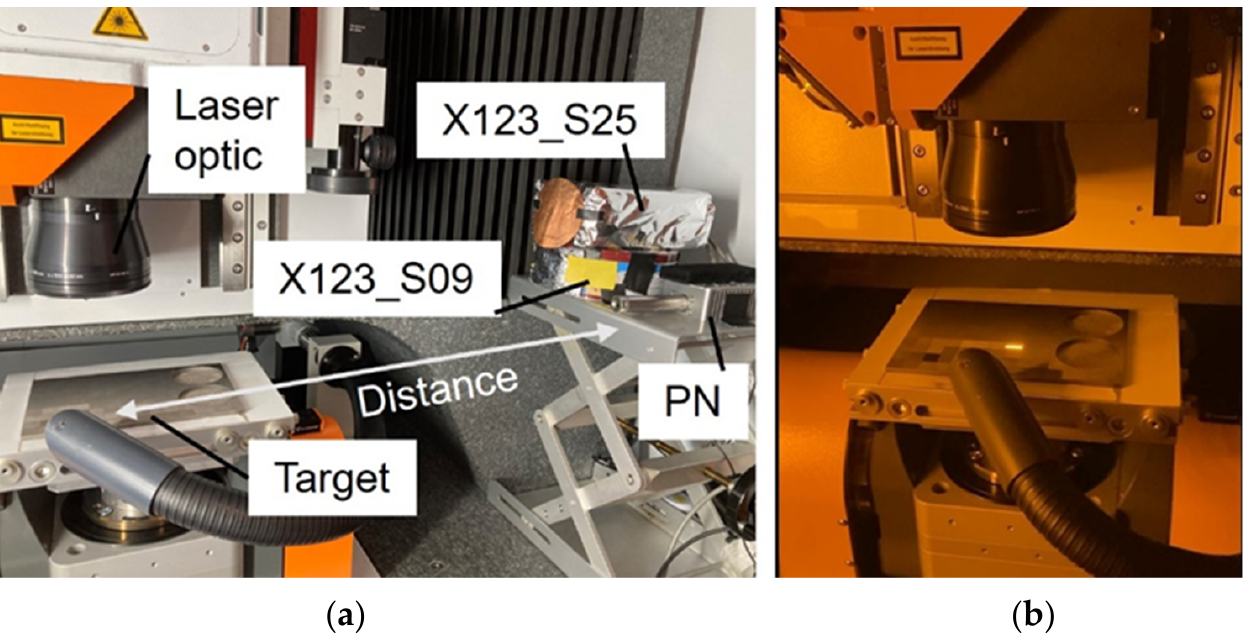
Figure 1. Experimental setup, ( a ) Arrangement of the spectrometers, ( b ) Image during laser processing. The X-ray emission investigations showed EMC issues for both CdTe spectrometers (X-123). The SDD (PN) was not affected. To reduce the influence due to the EMC issues, the X-123 spectrometers were encased in special housings. The X123_S09 was placed in a tinplate box and the X123_S25 in an aluminum box. To further suppress electronic noise, aluminum foils were put in front of the measurement window. The thickness of the aluminum foils (different thicknesses for X123_S09 and X123_S25) was calculated from absorption measurements using an X-ray tube with and without aluminum foils (see Section 3.1). To evaluate the influence of pile-up effects on the measured spectra, the measurements were performed with and without a 50 µ m thick copper foil (see Section 3.1). The placement of the spectrometers with respect to the X-ray emission source and its spatial homogeneity was controlled with a radiographic imaging plate placed at a distance of 60 cm from the laser-induced emission source about 10 cm in front of the three spectrometers. A 2-D Radiography Scanner CR 35 NDT Plus system (DÜRR, Stuttgart, Germany) was used. Figure 2a shows the grayscale image of the X-ray field recorded by the 2-D radiography plate along with the positions of the detectors that are marked by green, red, and blue circles, respectively. To compare the X-ray intensities arriving at the three spectrometers, the recorded data contained in the blue and yellow boxes were then binned vertically and then plotted as a function of the horizontal position in Figure 2b as blue and yellow curves. The additional green, red, and blue vertical lines mark the individual positions of the three spectrometers, while the corresponding horizontal lines indicate the average grayscale level as a measure of the local X-ray intensity incident to the detector. The spectrometer that received more intensity of laser-generated X-ray intensity (a higher average grayscale value) was the X123_S09. The X123_S25 and the PN received in comparison to X123_S09 about 14.5% and 24% less X-ray intensity during the